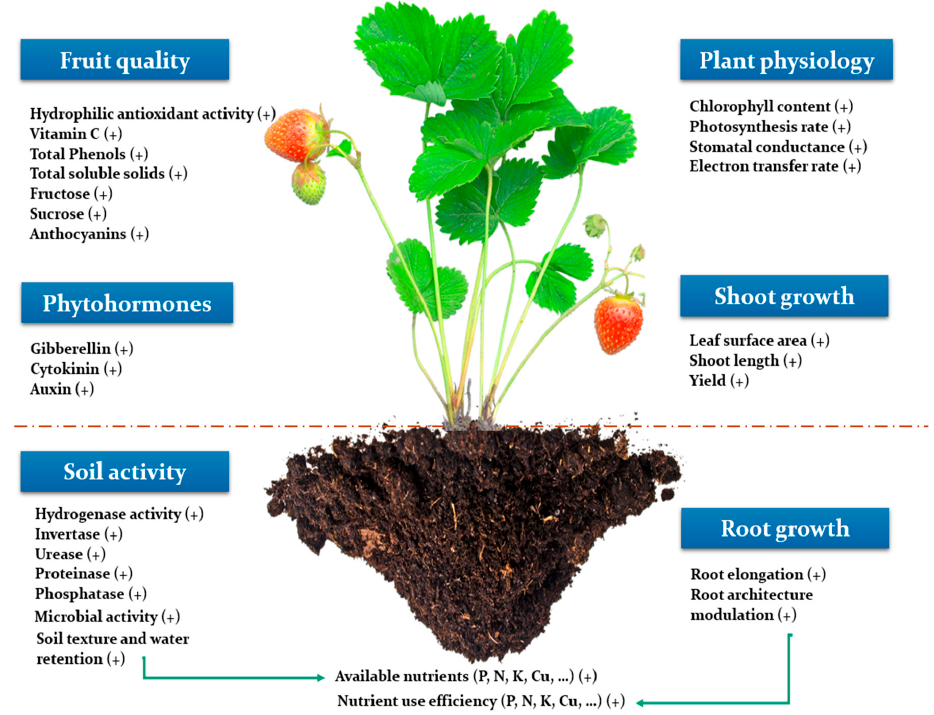
Figure 2. Conceptual illustration highlighting the positive impact of seaweed extracts on the whole